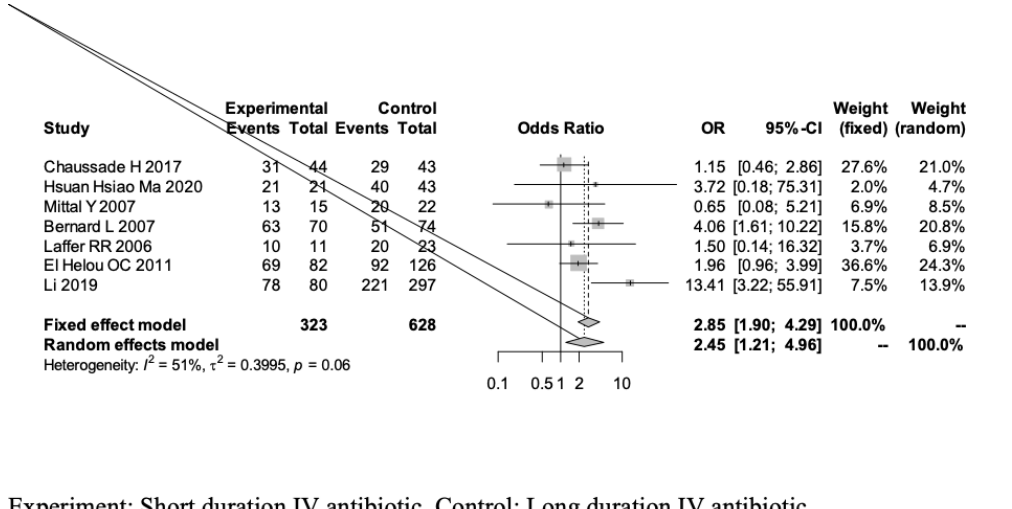
Figure 3. A forest plot outlining the adjusted success rate of short-duration (experimental) and long-duration (control) IV antibiotic treat- ments in THA- or TKA-related